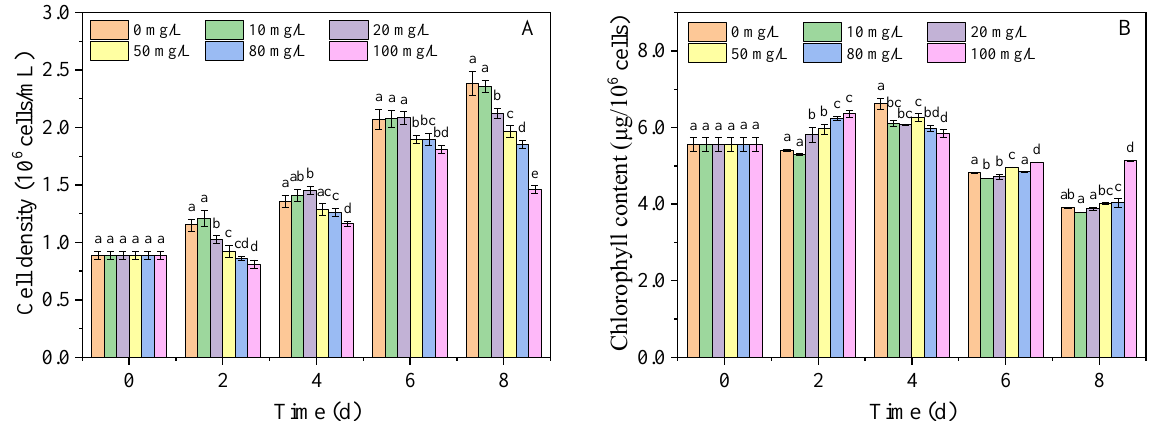
Figure 1. Cell density ( A ) and chlorophyll content ( B ) of A. carterae at different concentrations of nano-PS. Different letters represent significant differences ( p < 0.05).